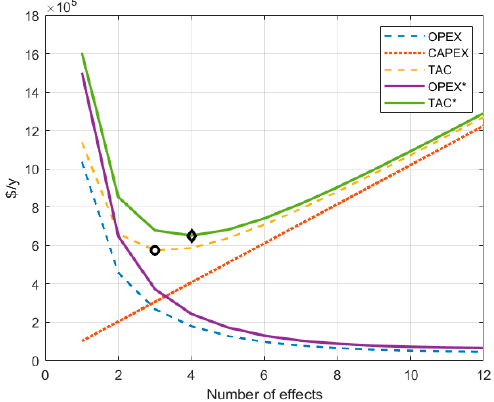
Figure 5. Multiple-effect TAC under uncertain operating conditions (Gamma PDF).